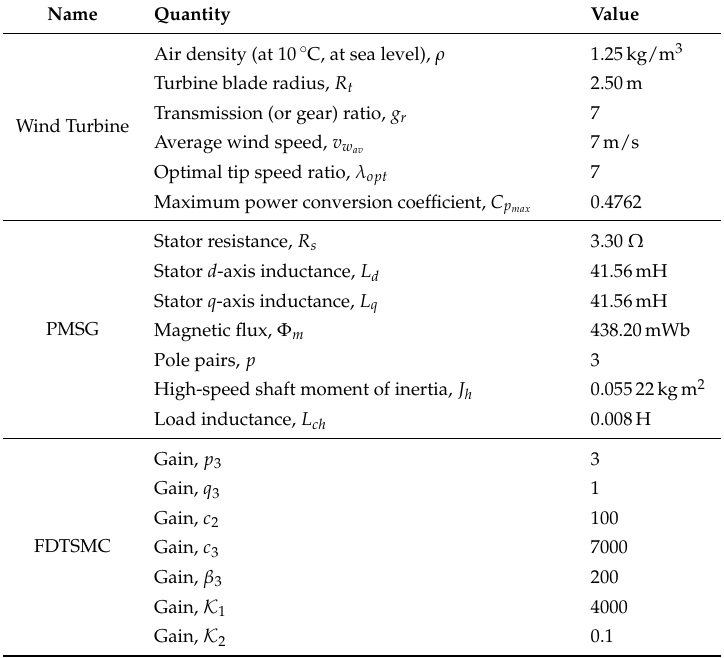
Table 1. PMSG–WECS and the proposed maximum power point tracking (MPPT) controller